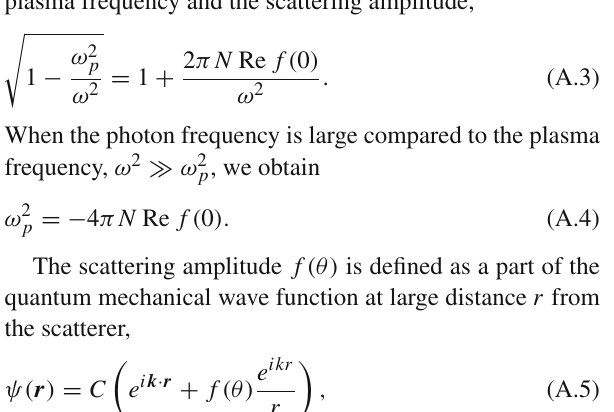
The closest thing to the scattering amplitude f in